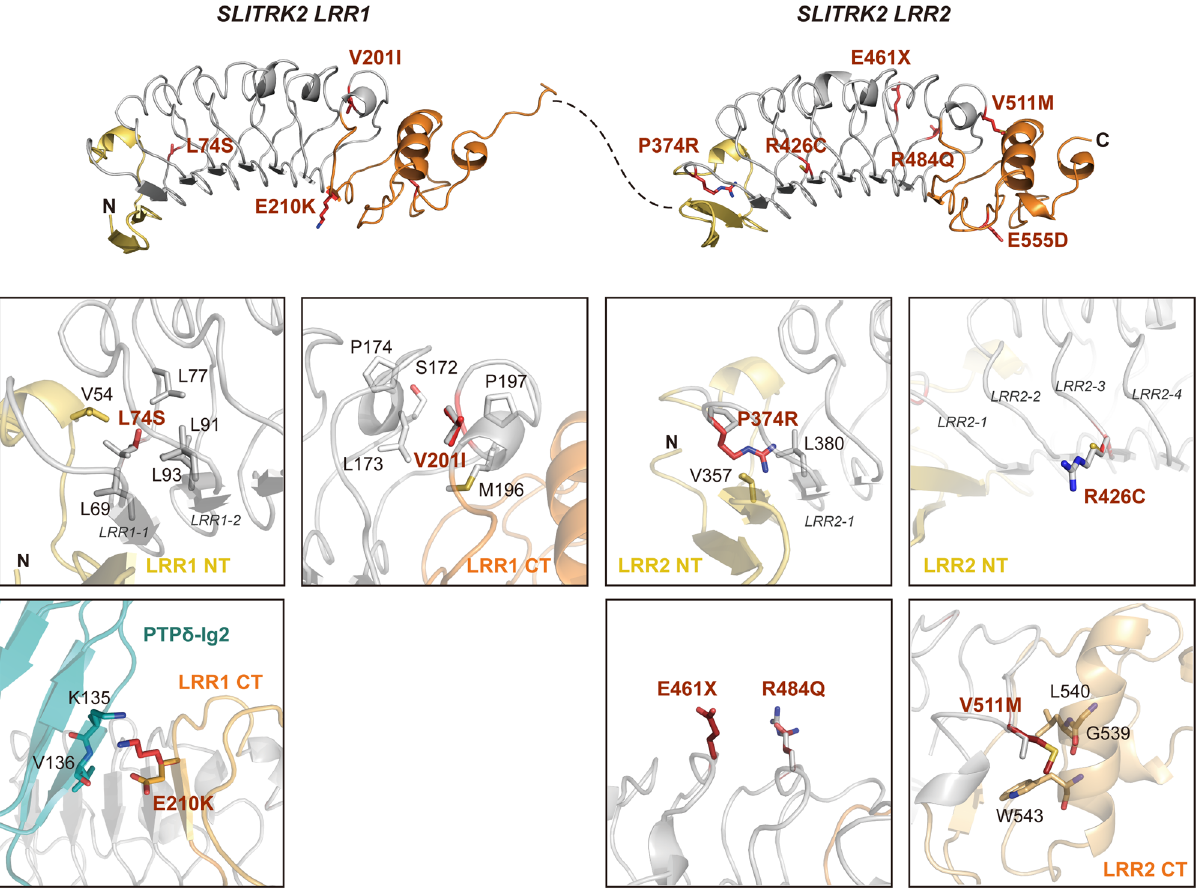
Fig. 2 Structural model of human SLITRK2 and patient variants. Model structure of human SLITRK2 LRR1 and LRR2 domains presented as a cartoon. Top: LRR1 domain, C33-D270 (left); LRR2 domain, P341-P579 (right). LRR N-terminus, LRR motifs, and LRR C-terminus are depicted in yellow, gray, and orange, respectively. Black dotted lines represent fl exible linkers between LRR1 and LRR2 domains. Bottom: Close-up views of mutated and neighboring residues in LRR1 and LRR2 domains. Residues corresponding to patients ’ variants described in the current study are presented as red sticks and labeled. The structure of human PTP δ Ig2 (teal) from the crystal structure of the human SLITRK1/human PTP δ Ig1-3 (PDB ID:4RCA) complex was used as a reference for potential interactions between human SLITRK2 and PTP δ Ig2. For clarity, the human SLITRK2 model is rotated 90° around the x-axis in the close-up views of E210K, E461*, R484Q, and